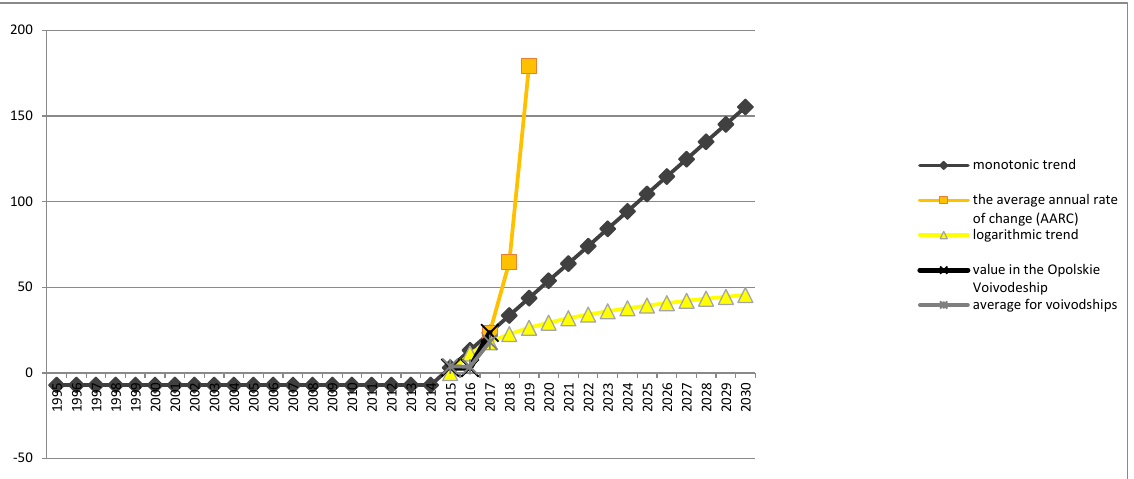
Figure 6. Share of buses running on alternative fuel in the total number of buses used in the urban transport services (%). Source: own